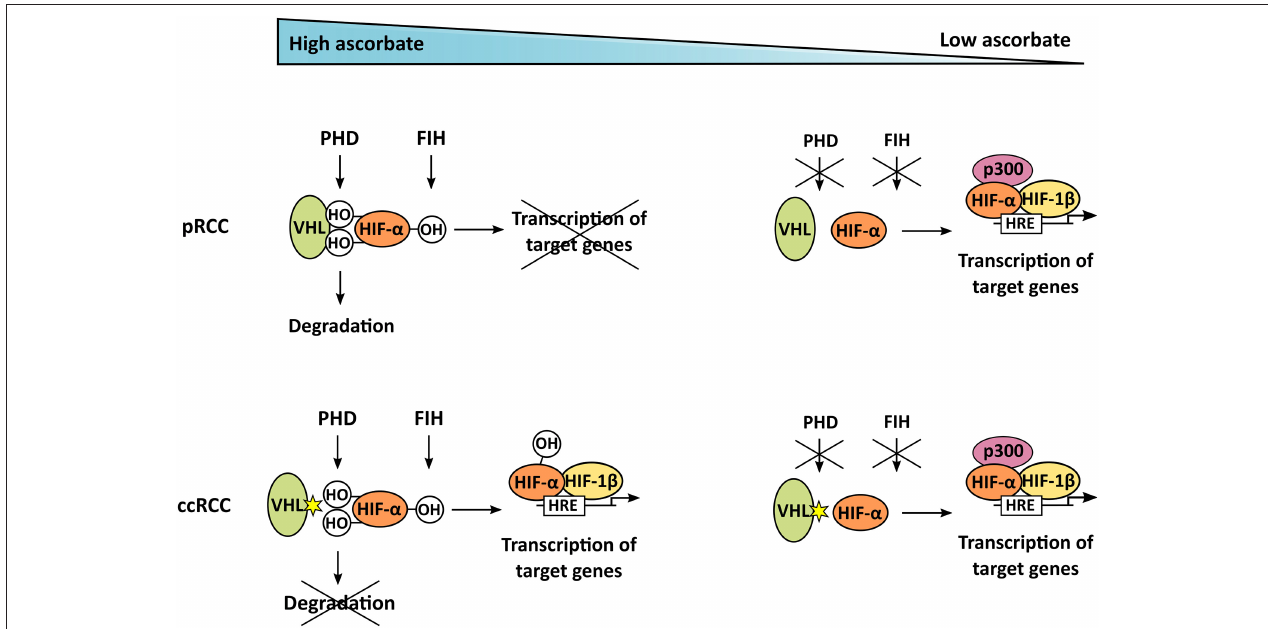
FIGURE 6 | Mechanism of ascorbate-dependent HIF-regulation in pRCC and ccRCC. If enough ascorbate is present, HIF- α is hydroxylated by PHD and FIH. In pRCC, this enables binding of the VHL tumor suppressor, leading to degradation of HIF- α ; it also represses target gene transcription. In contrast to that, ccRCC tumors harbor mutations in VHL , resulting in uncontrolled accumulation and transcriptional activity of HIF- α , even if ascorbate is abundant and HIF is hydroxylated. In tumors lacking ascorbate, the hydroxylases are not fully functional, HIF- α is stabilized and can trigger target gene transcription after dimerization with HIF- β , and interaction with the p300 coactivator, in both pRCC and